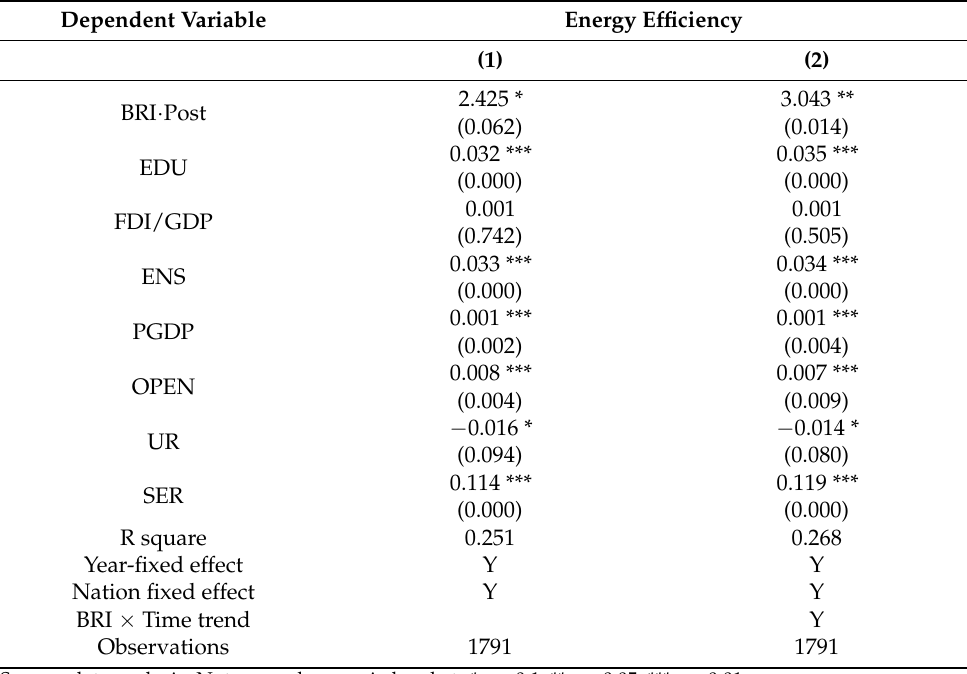
Table 1. Energy efficiency regression